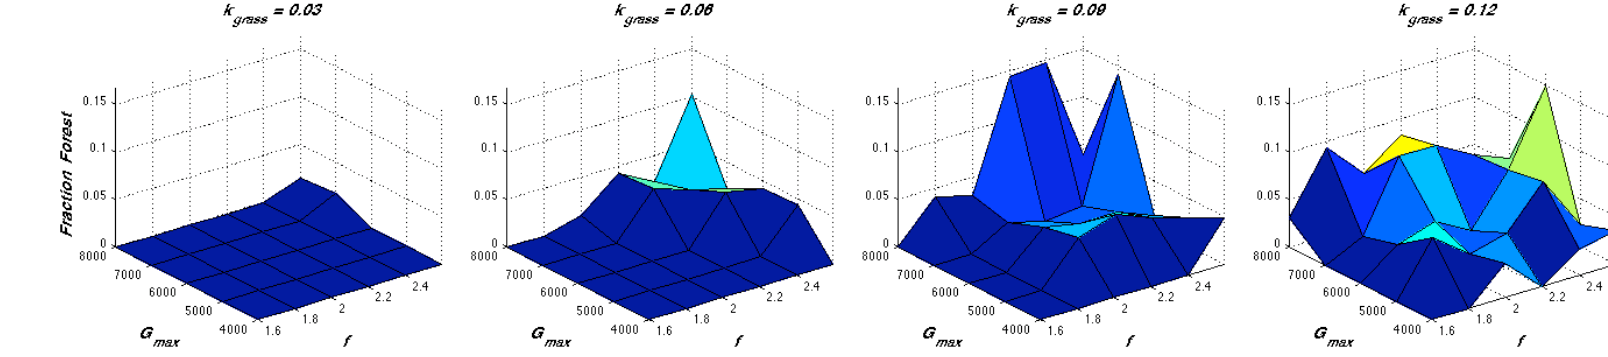
(kg/ha), scalar stocking factor f, and maximum intrinsic grass max